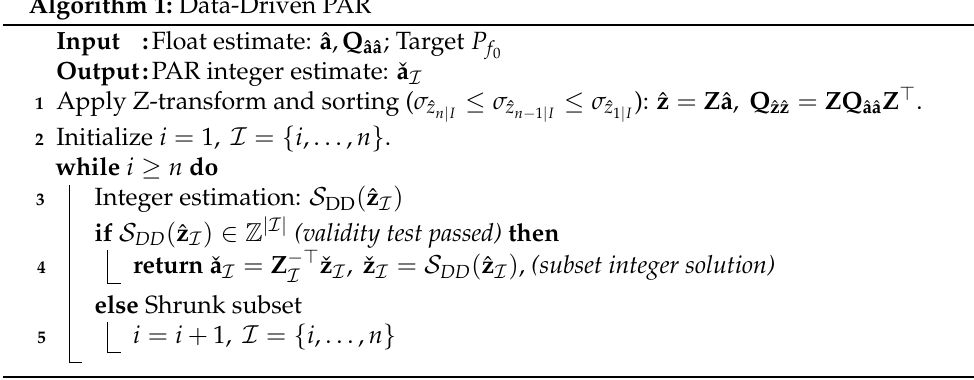
Algorithm 1: Data-Driven